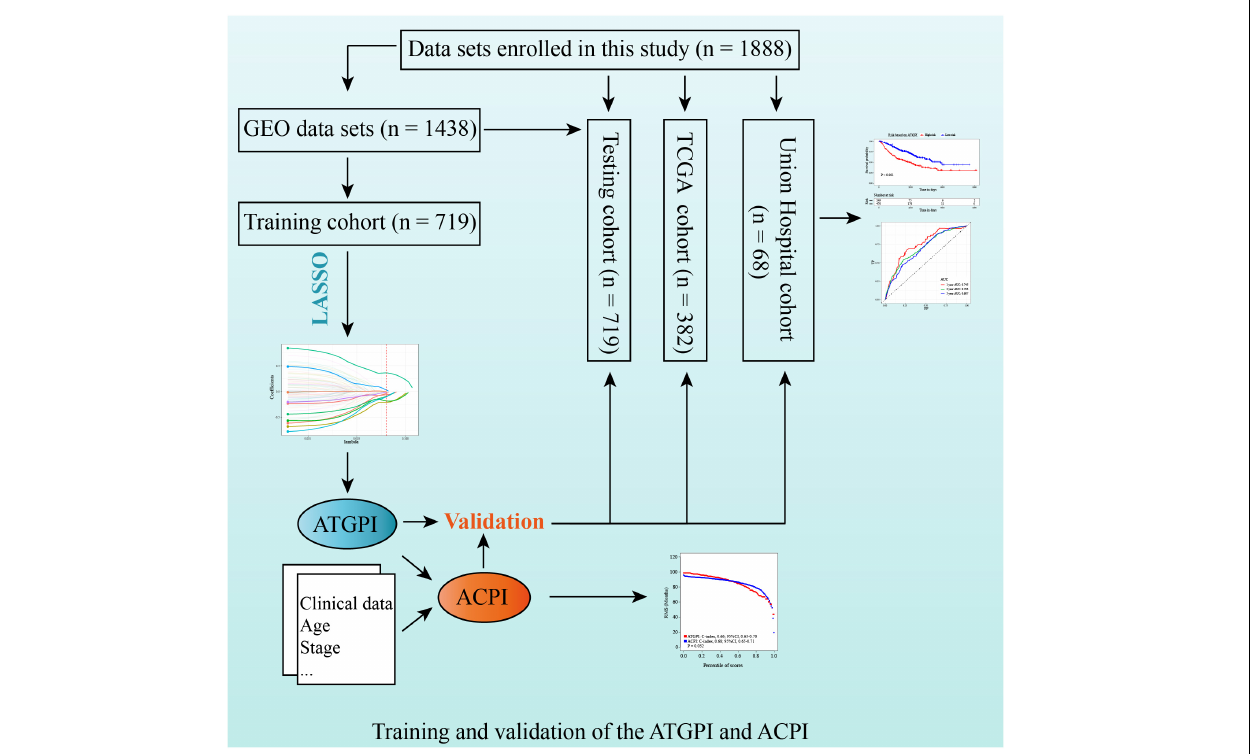
ATGPI using Cox proportional hazards regression. Based on the time-dependent ROC curve analysis, the optimal cutoff value for ATGPI was 1.35 ( Figure 2C ). Risk curve and scatterplot were used to determine ATGPI and the vital status of each patient. Patients in the high-ATGPI group had higher mortality than those in the low-ATGPI group ( Figures 2D,E ). Survival curves of different groups were estimated using the Kaplan– Meier method and were compared using the log-rank test ( P < 0.001) ( Figure 2F